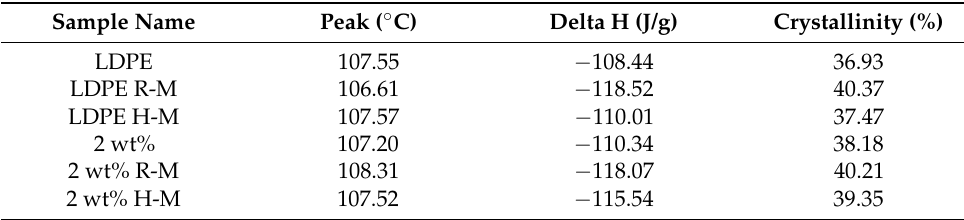
Figure 4. Comparison of the crystallinity of the LDPE and the 2 wt% composites. Table 1. Crystallinity of LDPE and 2 wt%